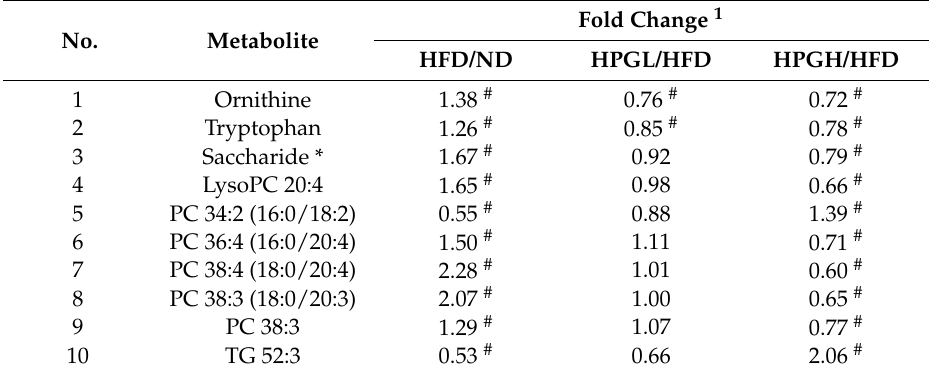
Table 3. List of potential serum biomarkers in mice fed a High-Fat Diet (HFD) including 5% Platycodon grandiflorum using various MS